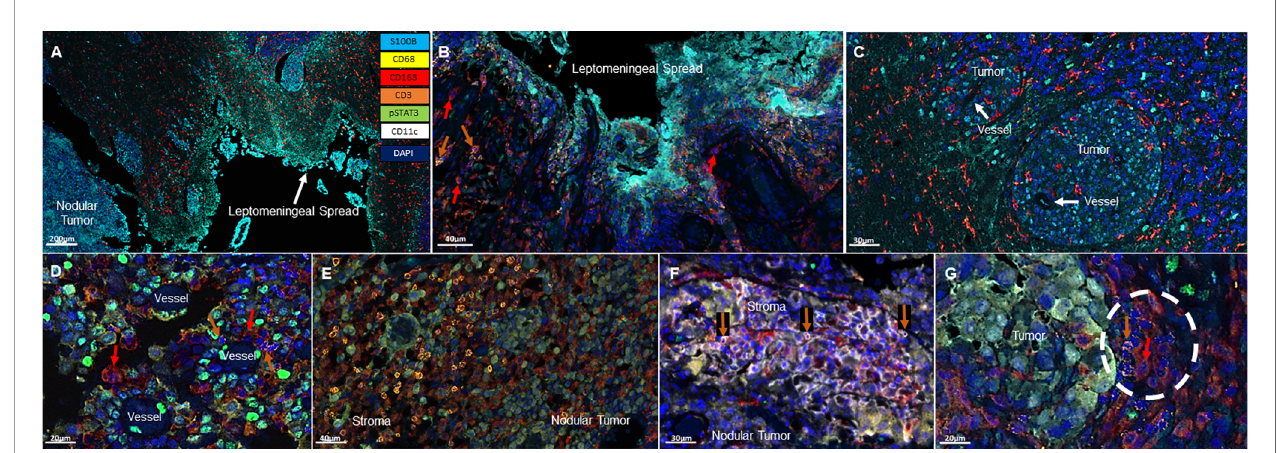
FIGURE 1 | Representative immuno fl uorescent multiplex fi ndings in melanoma LMD. (A) Gross fi ndings of nodular tumor that was resected adjacent to the region of leptomeningeal spread. The specimens were stained with 7-color opal multiplex staining technique consisting of: Cyan-S100B tumor, Yellow-CD68, Red-CD163, Orange-CD3, Green-pSTAT3, White-CD11c and dark Blue-DAPI. (B) Higher magni fi ed view of another image of LMD that displays CD163+ macrophages (red arrows) and occasional CD3+ T cells (orange arrows). (C) Perivascular cuf fi ng of melanoma cells demonstrating abundant CD163+ macrophage in fi ltration. (D) In nodular melanoma, CD163+ macrophages (red arrows) and CD3+ T cells (orange arrows) are visualized in the perivascular areas. (E) CD3+ T cell in fi ltration in the stroma of nodular melanoma. (F) CD11c+ and CD3+ (orange arrows) cells cluster in the stroma of nodular melanoma. (G) CD163+ (red arrow) and CD3+ (orange arrow) cluster seen at the interface of the melanoma and the